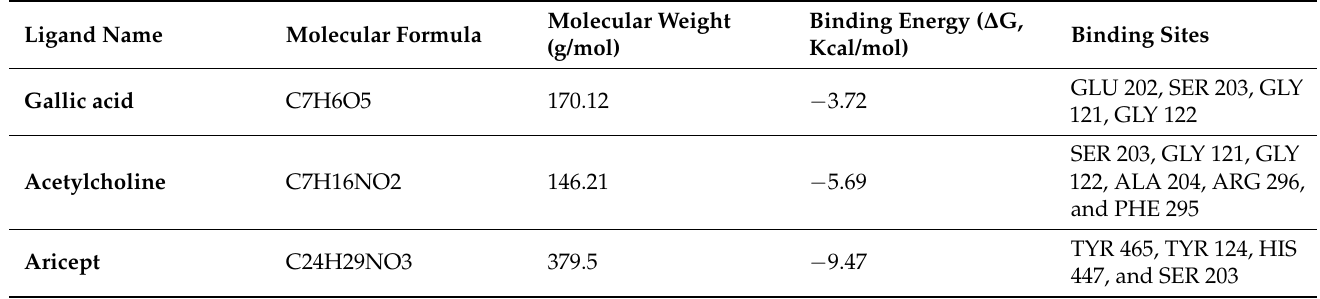
Table 3. Docking substrates with AChE (PDB: 4EY7) and predicted binding